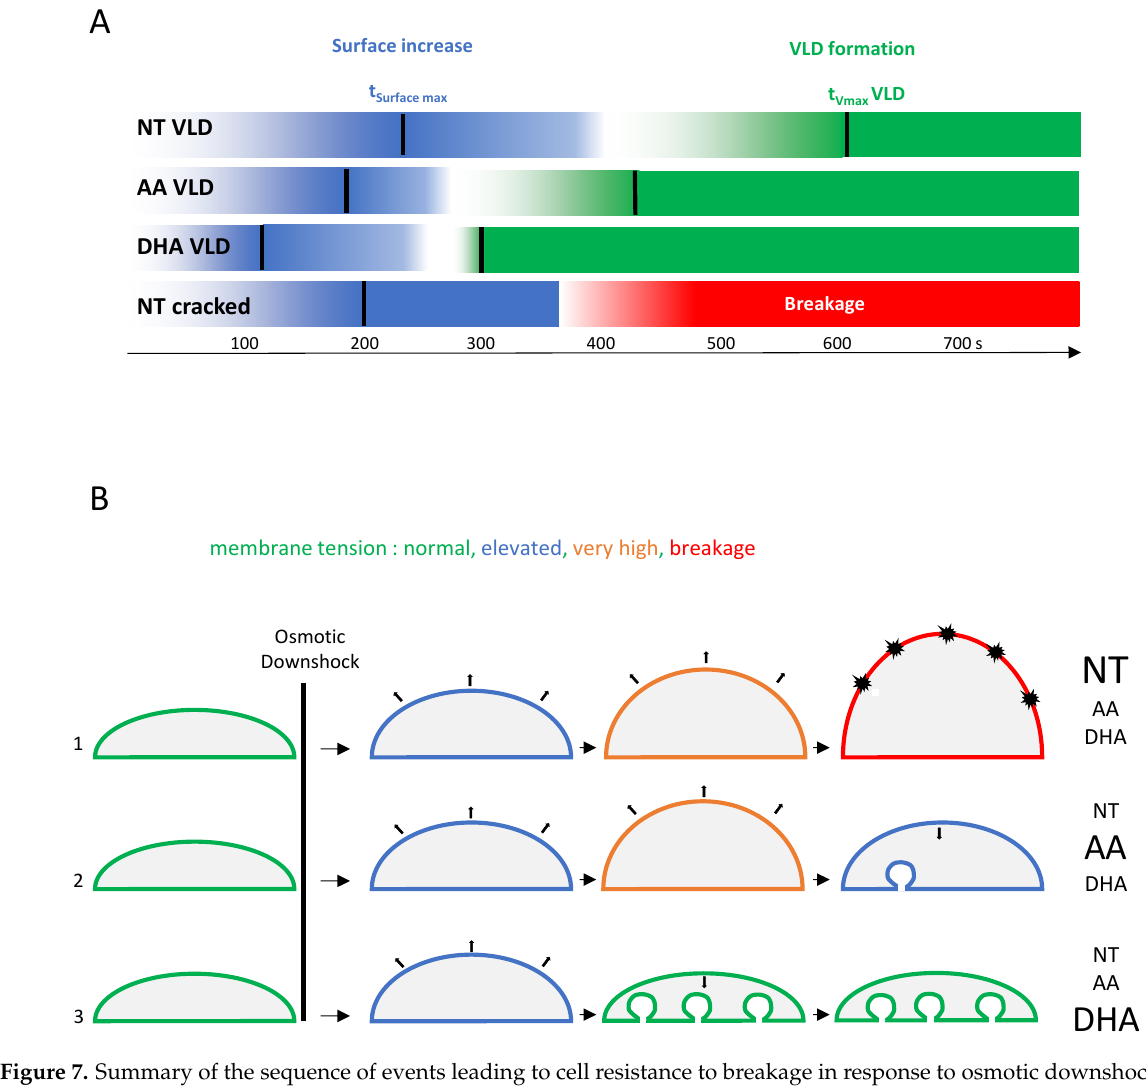
( G ) t0 of VLD formation (t0 VLD; t0 in Figure 5F). ( H ) t breakage, corresponding to the time when cell breakage occurred